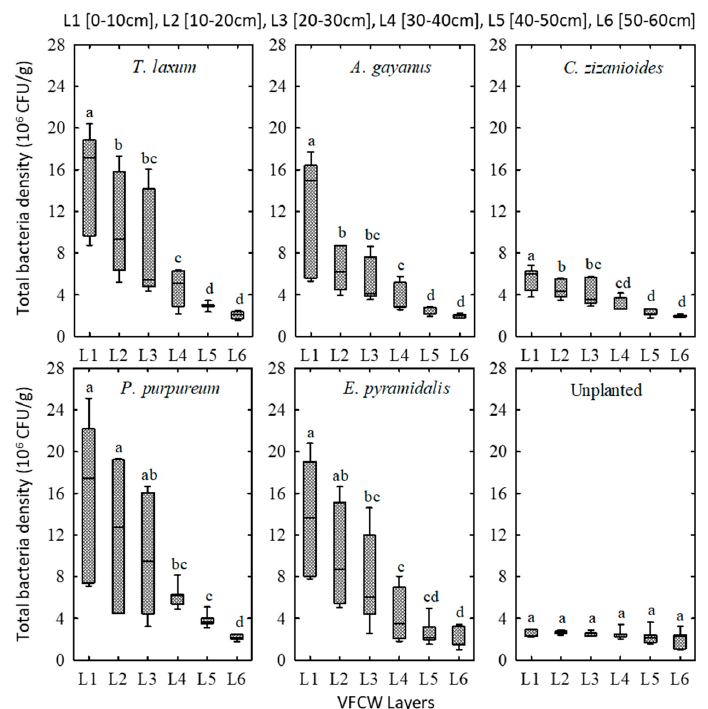
Figure 6. Vertical profile of total bacteria density in the different substrate layers of the pilot VFCW beds from the upper to the bottom layers: L1 [0–10 cm], L2 [10–20 cm], L3 [20–30 cm], L4 [30–40 cm], L5 [40–50 cm], L6 [50–60 cm]. Box-plots bearing the same letter indicate no significant difference ( p > 0.05).